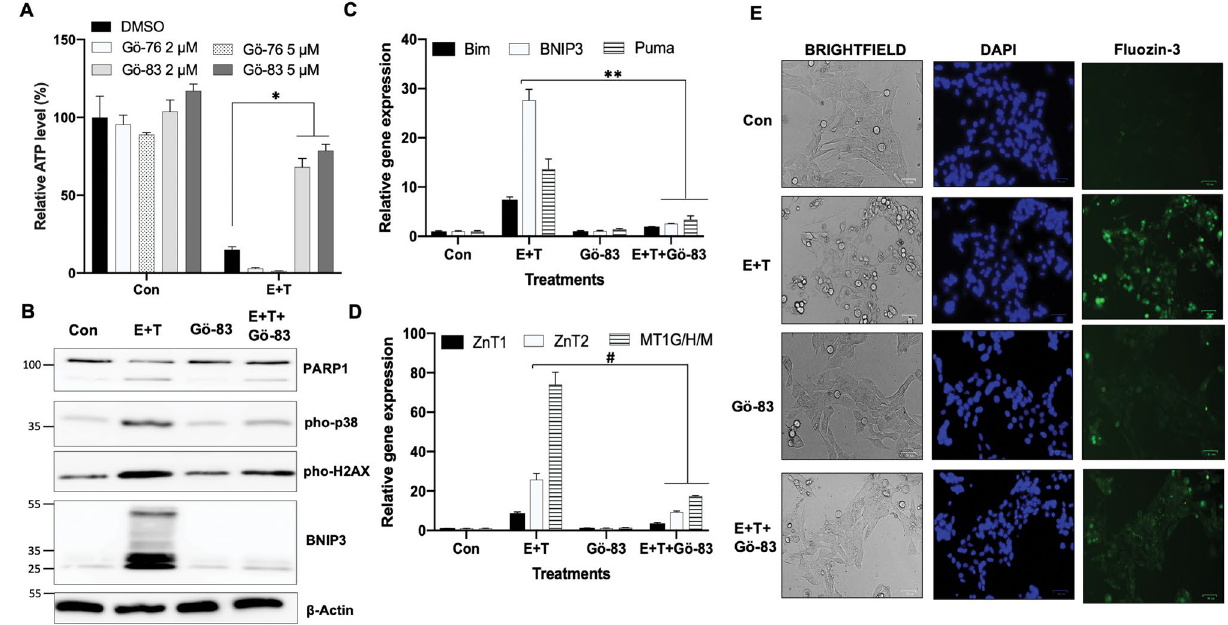
Figure 6. Inhibition of PKC suppresses increase of labile zinc and cell death. (A) Relative cell survival of HCC38 cells under either control or 5 μM erastin and 5 μM tubacin (E + T) treatments with or without PKC inhibitor Gö 6976 or Gö 6983 for 72 h (n = 3; *p < 0.005). (B) Western blot analysis in HCC38 cells that were treated as ( A ) for 24 h. (C,D) RT-qPCR expression analysis of apoptotic genes ( C ; **p < 0.001) and zinc-related genes ( D ; # p < 0.0001). (E) Living cell imaging of HCC38 cells that were treated as ( A ) for 18 h and stained by Fluozin-3 and DAPI (Hoechst 33342). The size of the scale bar is 50